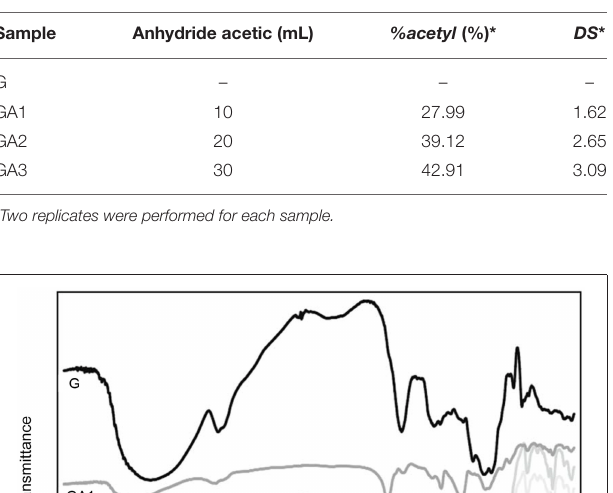
TABLE 1 | Acetylation degree ( %acetyl ), degree of substitution ( DS ), for unmodified galactomannan (G) and galactomannan treated with different volumes of anhydride acetic (GA1, GA2, and GA3).